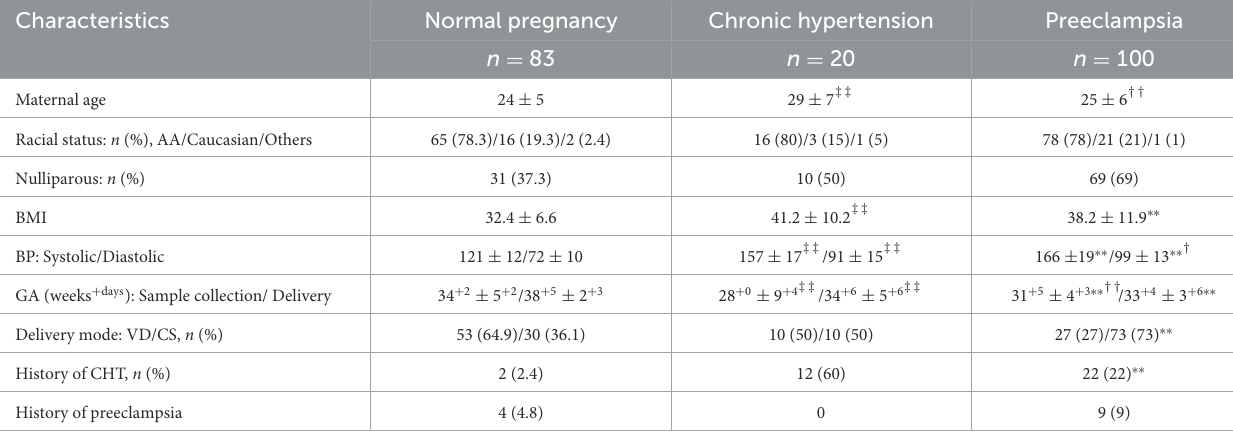
TABLE 1 Demographic data of study subjects from whom plasma and urine samples were analyzed. Characteristics Normal pregnancy Chronic hypertension